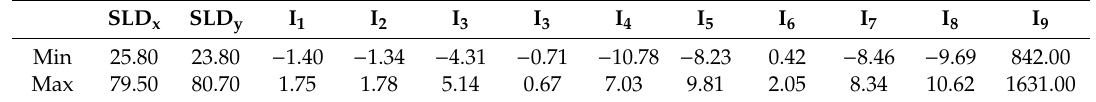
Table 2. Normalization parameters of training